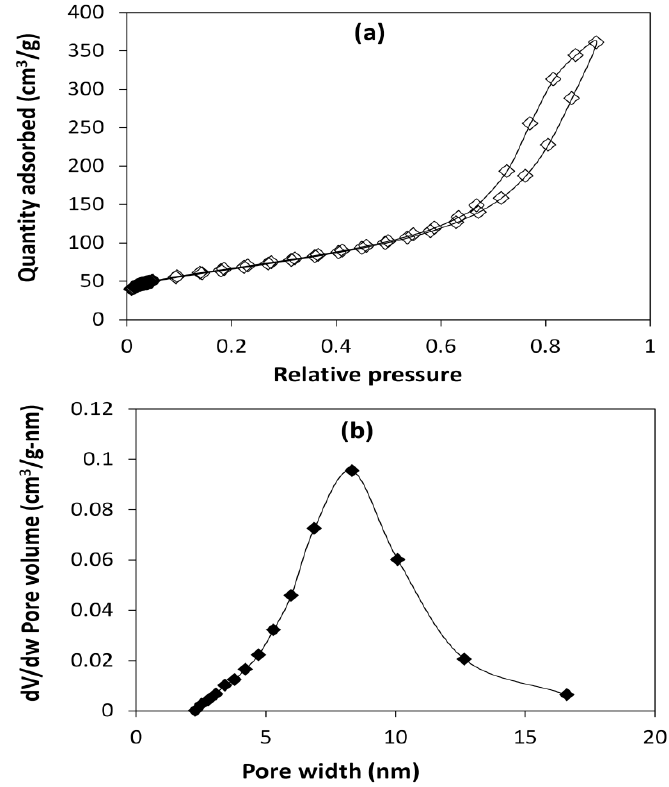
Figure 1. Catalyst characteristics of ( a ) nitrogen adsorption–desorption isotherm and ( b ) the pore size distribution.